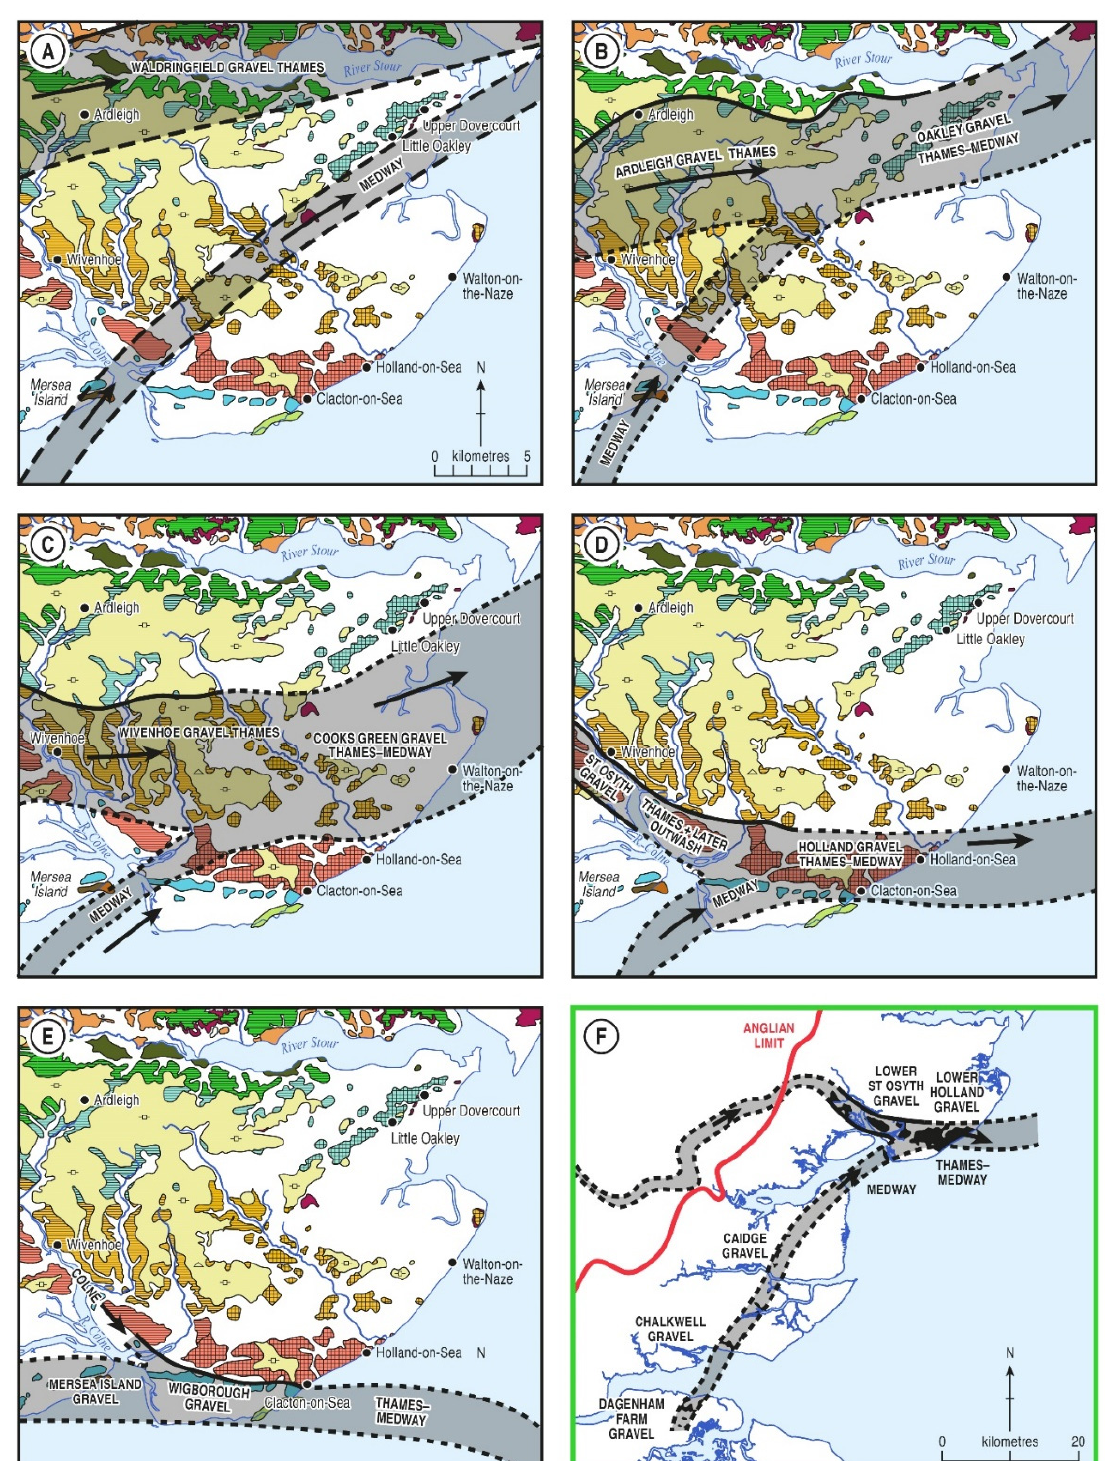
Figure 4. Former courses of the Thames–Medway system across the study area, derived from the Tendring Geodiversity Audit of Essex County Council [35] (original sources [9,31]). ( A )—Waldring- field Gravel; ( B )—Adleigh–Oakley Gravel; ( C )—Wivenhoe Gravel; ( D ). St Osyth–Holland Gravel; ( E )—the first post-diversion course; ( F )—the wider St Osyth–Holland Gravel course, showing the relation to the ice limit (Table 1).